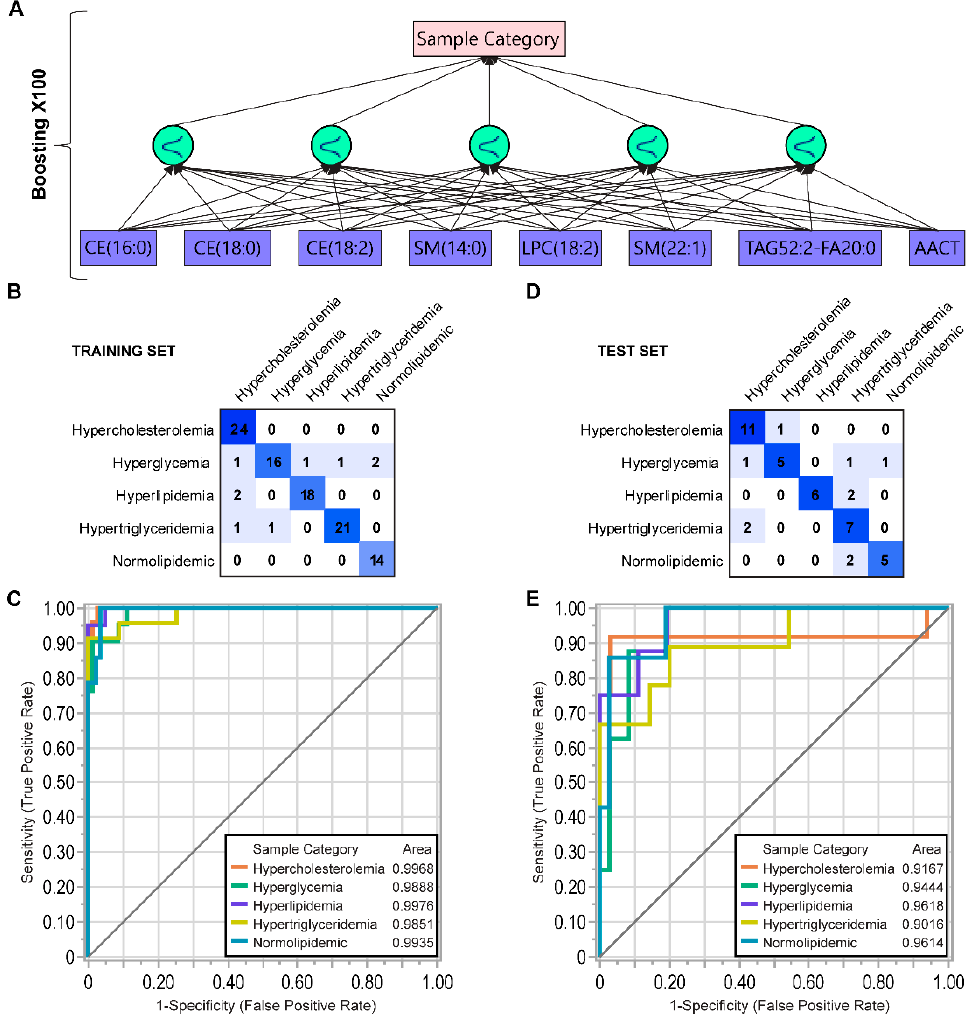
Figure 5. Summary of ANN machine-learning predictive modeling for metabolic conditions. ( A ) MLP neural network diagram with 8 predictors and five Gaussian activation function nodes in the hidden layer. Confusion matrix and ROC curve for the training set ( B ) and ( C ), and test set ( D ) and ( E ).